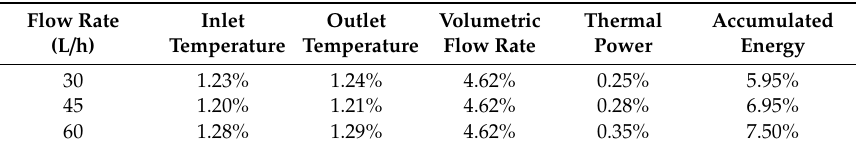
Table 3. Maximum relative errors in the water inlet and outlet temperature the flow rate, the power and the accumulated